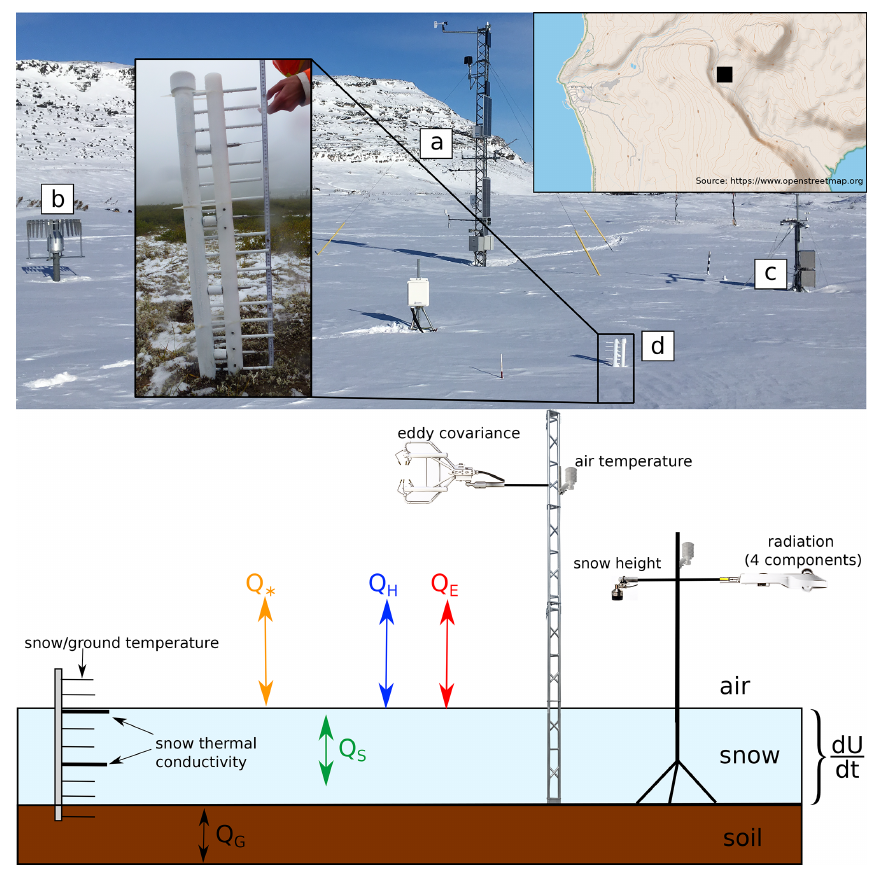
Figure 1. Upper panel: study site with (a) the main 10m flux tower with the eddy covariance setup, (b) a precipitation gauge, (c) a 2.3m high mast hosting the four-component radiometer, and (d) a vertical pole holding an array of thermocouples and heated needles. The inset map shows the location of the site in the Tasiapik valley, some 4km east of Hudson Bay. Lower panel: schematic of the study site illustrating the main instruments monitoring energy balance terms. The whole experimental setup is contained within